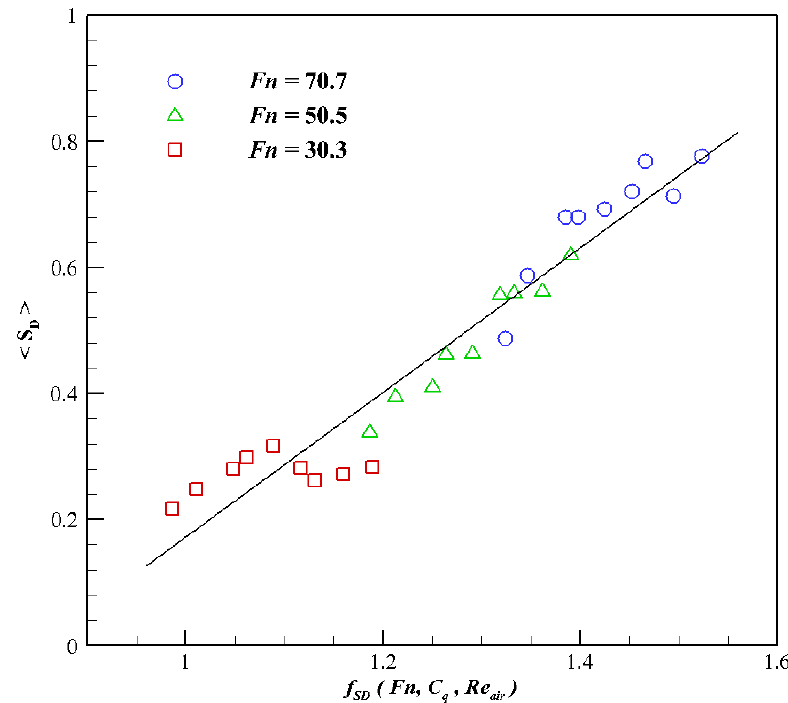
Figure 15. The time-averaged spatial density, < S D > is shown against f SD , which is a function of Froude number, Fn , air injection coefficient, C q , and Reynolds number, Re air . The linear fit between the experimental measurements and the power–law model is indicated by a straight line having R 2 =